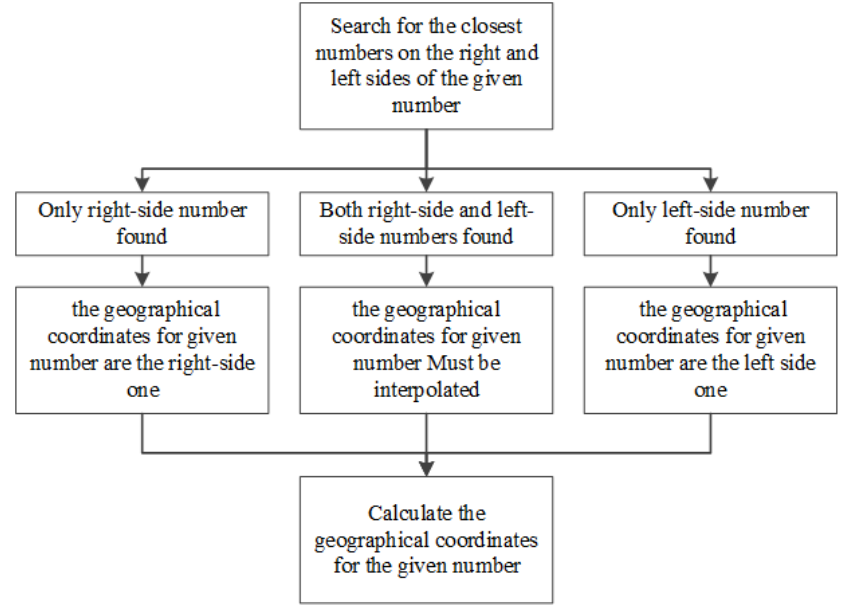
Figure 7. The flow chart of the interpolation algorithm for address matching.